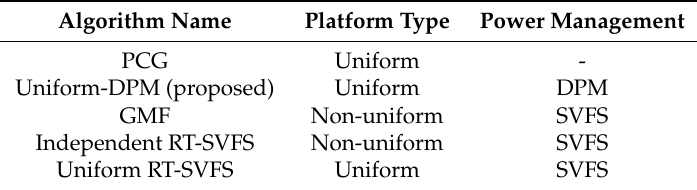
Table 13. Summary of the energy-efficient scheduling